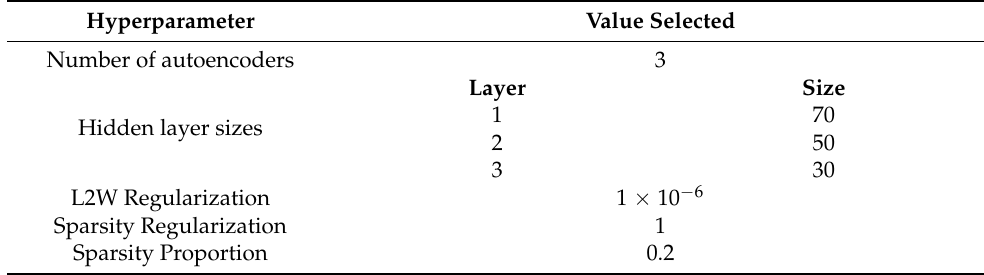
Table 1. Resulting hyperparameters for the implementation of the stacked autoencoder.